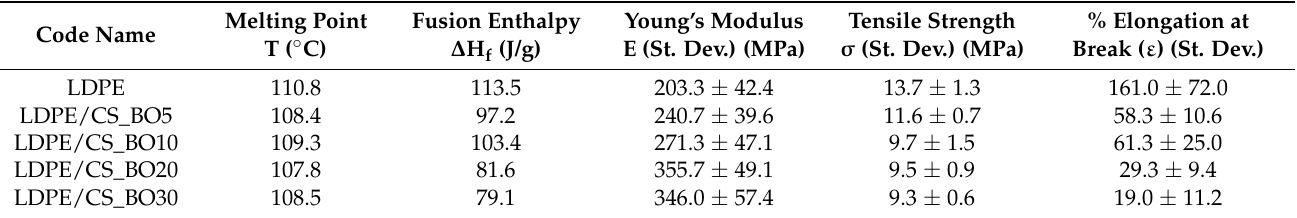
Table 1. Melting point temperature, fusion enthalpy values among with Modulus of elasticity (E), tensile strength ( σ uts ), and % elongation at break ( ε b ) of all tested LDPE/CS_BO films.